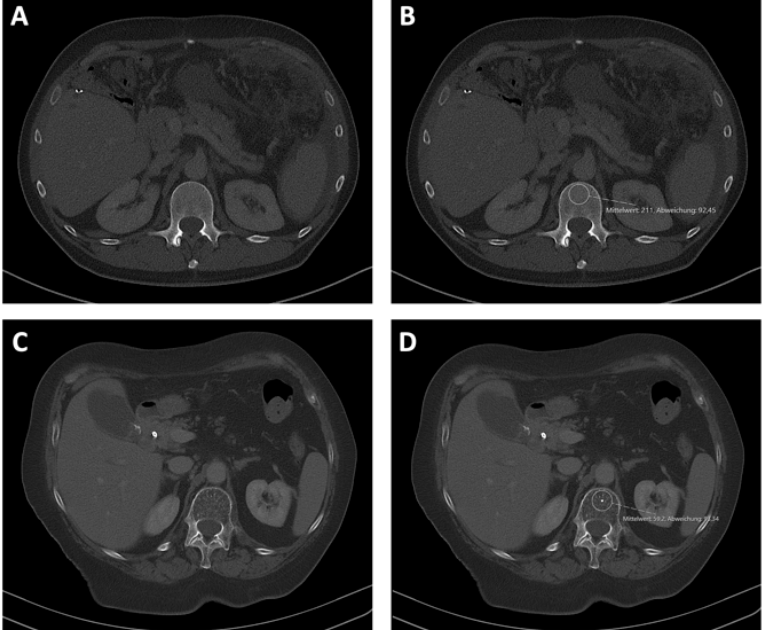
Figure 2. Assessment of BMD at the level of the first lumbar vertebra. BMD was assessed using CT in venous phase and the local PACS (IntelliSpace PACS, Philips, Amsterdam, The Netherlands). Examples of high ( A , B ) and low ( C , D ) BMD values with ( B , D ) or without ( A , C ) displayed